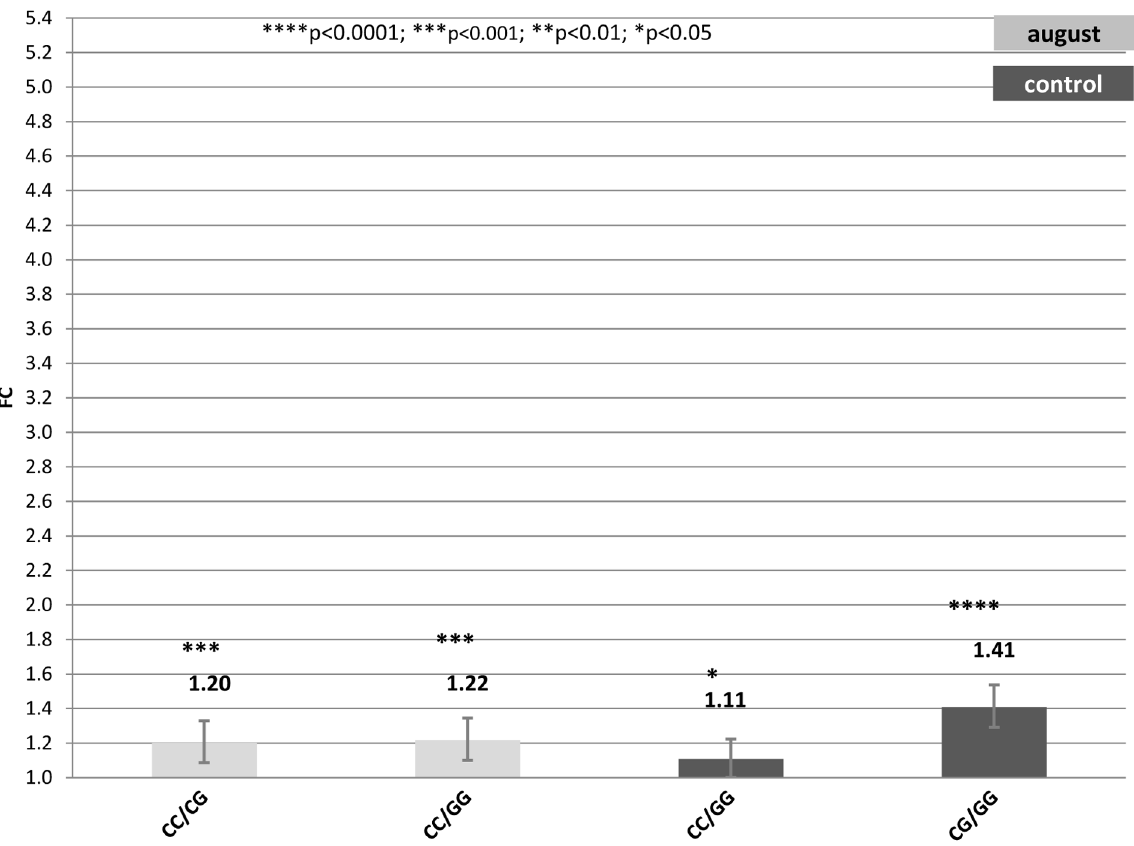
Figure 3. Fold change (FC) for the contrast among alternative genotypes G/C 2 660 of the HSP90AA1 promoter within each treatment (Control, July and August) normalized by HSP90AB1 . Segments indicate the 95% confidence interval (FC up -FC low ).In abscissa the FC, in ordinate genotype contrast. Asterisk over each bar indicates the significance level of the contrasts.